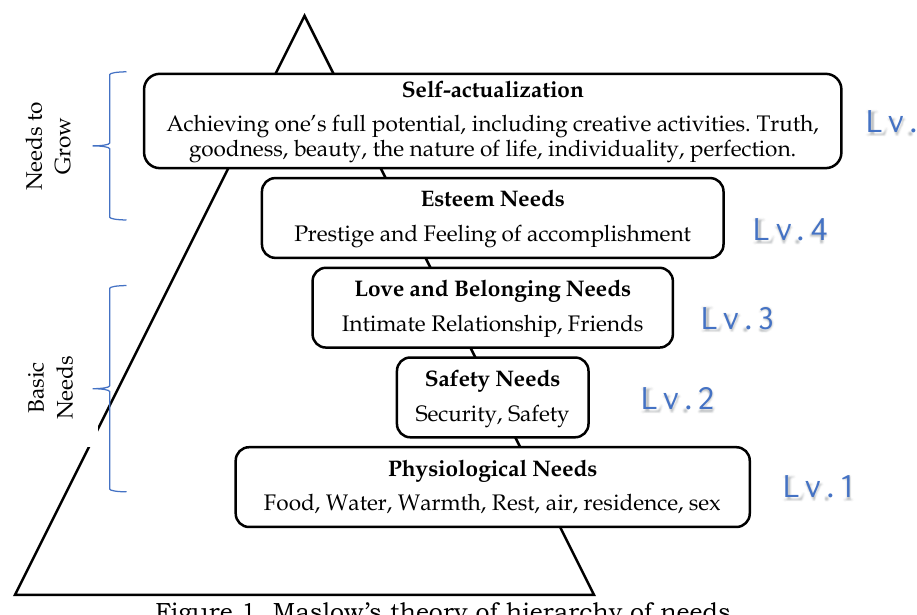
Figure 1. Maslow’s theory of hierarchy of